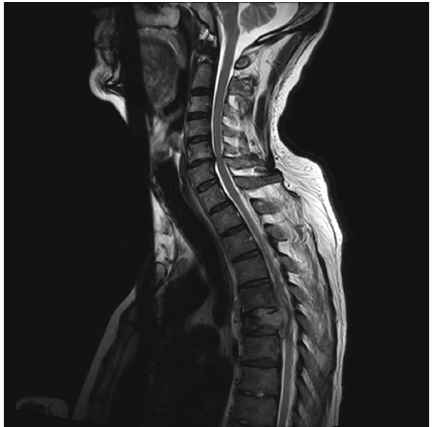
Figure 3: MRI scan, axial T1 weighted image, showing posterior soft tissue mass at the level of T5 with associated pathological fracture and diffuse paravertebral oedema. There is evidence of moderate compression of the spinal